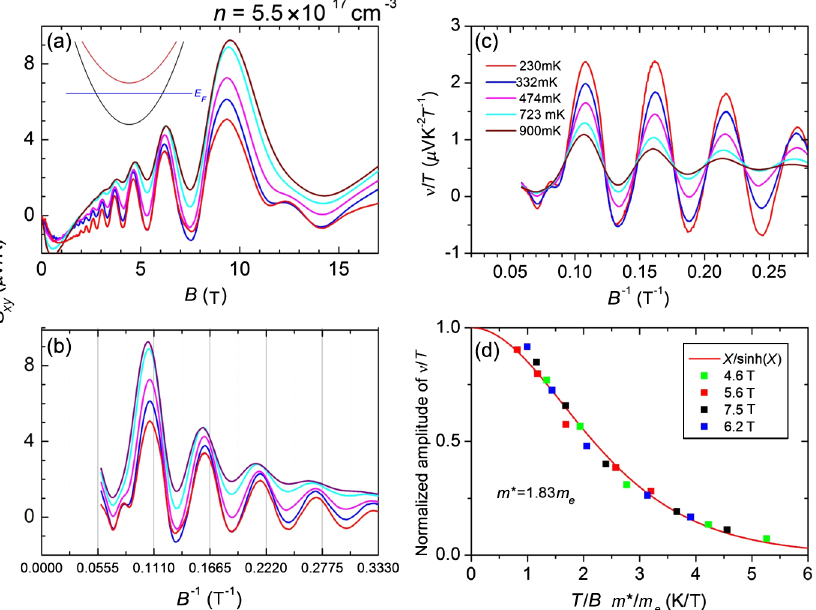
FIG. 3. Nernst quantum oscillations as a function of (a) the magnetic field and (b) the inverse of the magnetic field at different temperatures for the sample with a carrier density of 5 : 5 (cid:1) 10 17 cm (cid:2) 3 . There is a single periodicity, with the lowest peak displaying Zeeman splitting. (c) The variation of the Nernst coefficient ( (cid:2) ¼ S xy =B ) divided by temperature, with the inverse of the magnetic field at different temperatures. (d) The amplitude of oscillations in (cid:2)=T for different magnetic fields and temperatures. The solid line represents the damping expected in the Lifshitz-Kosevitch theory for an effective mass of 1 : 83 m e